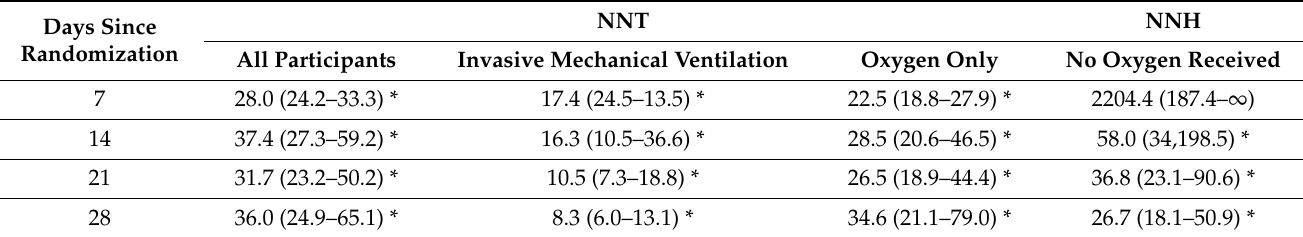
Table 2. NNT and NNH with 95%CI values of dexamethasone vs. usual care on mortality at 7, 14, 21, and 28 days according to respiratory support as reported by the RECOVERY study in patients hospitalized with COVID-19. NNT values indicate that dexamethasone was better than usual care, whereas significant NNH values imply that dexamethasone was worse than usual